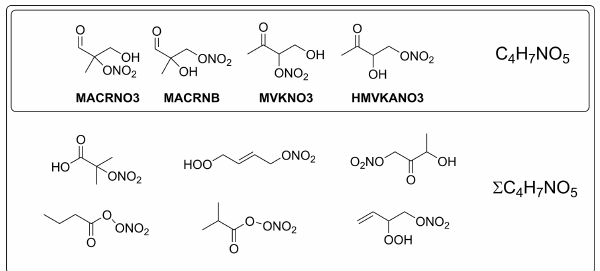
Figure 4. The four C 4 H 7 NO 5 species resulting from isoprene oxi- dation present in the MCM along with the additional isomeric com- pounds which complete the set of (cid:54) C 4 H 7 NO 5